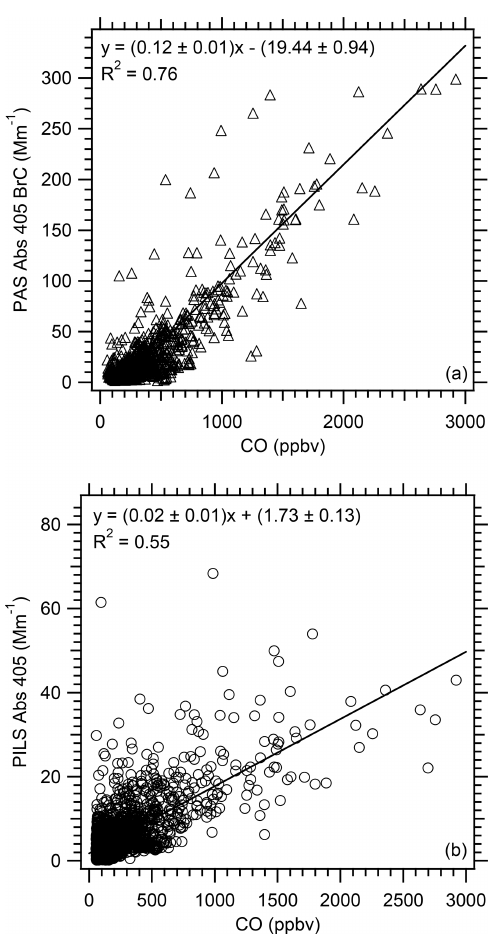
Figure 7. Correlation of (a) PAS total Abs 405 BrC and (b) PILS water-soluble Abs 405 vs. WSOC for all WE-CAN flights used in this analysis. Uncertainties with the least square regressions are 1 standard